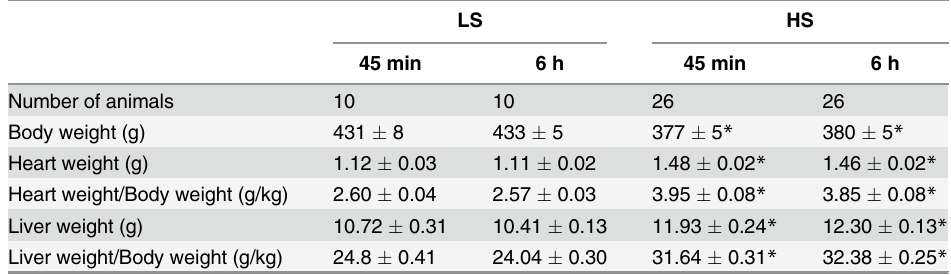
Table 3. Echocardiographic data of DS rats. 11 week-old 18 week-old LS HS LS HS Number of animals 20 52 20 52 Heart rate (bpm) 336 (cid:1) 11 369 (cid:1) 8 * 333 (cid:1) 8 405 (cid:1) 10 * Diastolic PWT (mm) 1.46 (cid:1) 0.04 1.95 (cid:1) 0.04 * LVDd (mm) LVDs (mm) 4.49 (cid:1) 0.13 FS (%) 55.8 (cid:1) 2.8 65.6 (cid:1) 1.3 * 49.2 (cid:1) 1.2 39.5 (cid:1) 1.4 * Values are expressed as the mean (cid:1) SEM. * P < 0.05 versus LS at the same age. DS rats , Dahl salt-sensitive rats; LS , rats fed a low-salt diet; HS , rats fed a high-salt diet; PWT , posterior wall thickness; LVDd , left ventricular diastolic dimension; LVDs, left ventricular systolic dimension ; FS , fractional shortening; SEM, standard error of the mean.